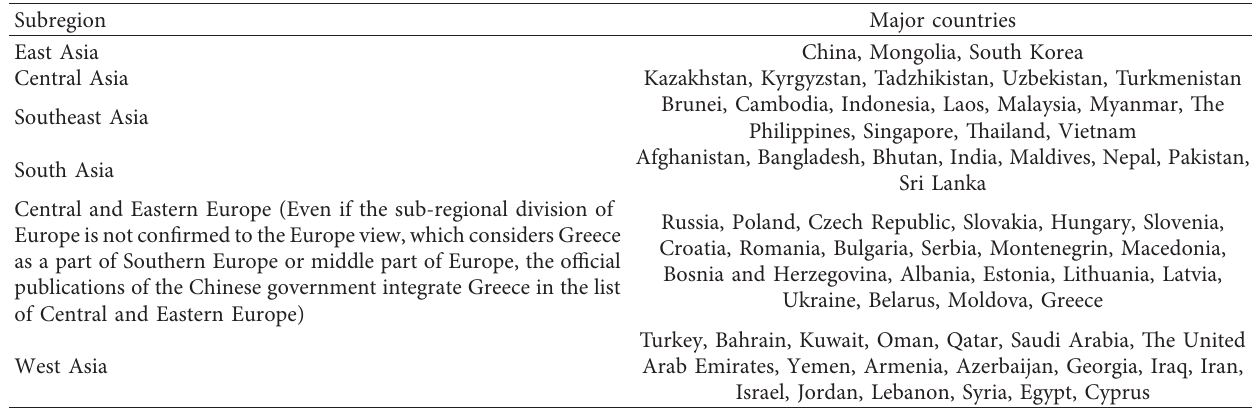
Table 1: Country list in B&R